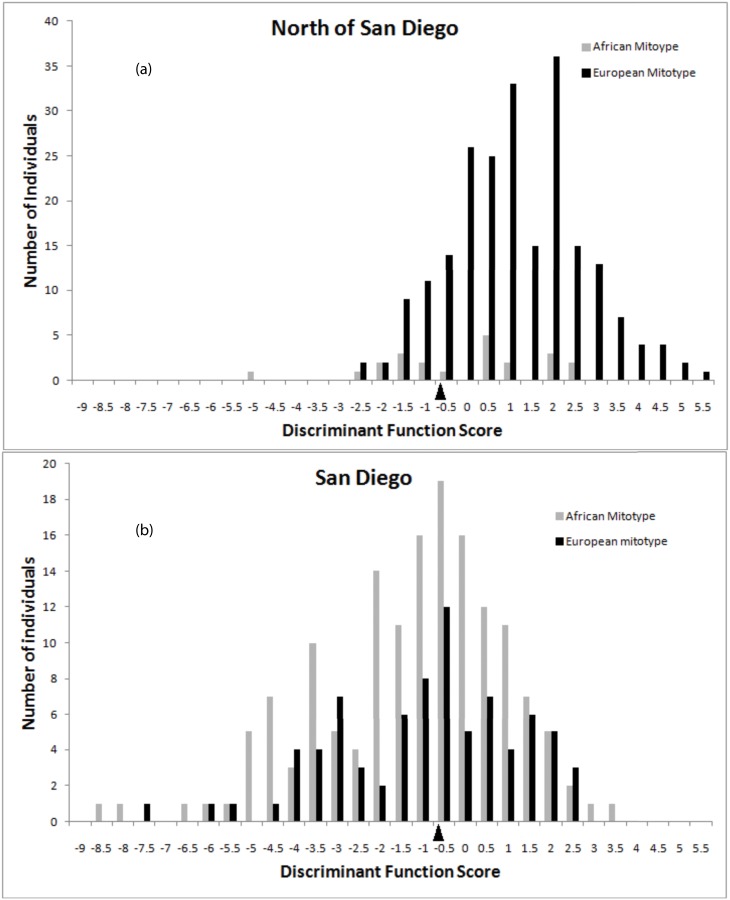
Distribution of morphological discriminant function scores for individual workers carrying European or African mitochondria sampled a) north of San Diego County and b) within San Diego County.Arrow indicates the midpoint between the mean discriminant function scores for individual European and Africanized workers [25]. Bees with scores smaller than the midpoint are classified by the discriminant function as Africanized while bees with scores larger than the midpoint are classified European. The expected misclassification rate of this discriminant function for individual workers is 9.9% [25].